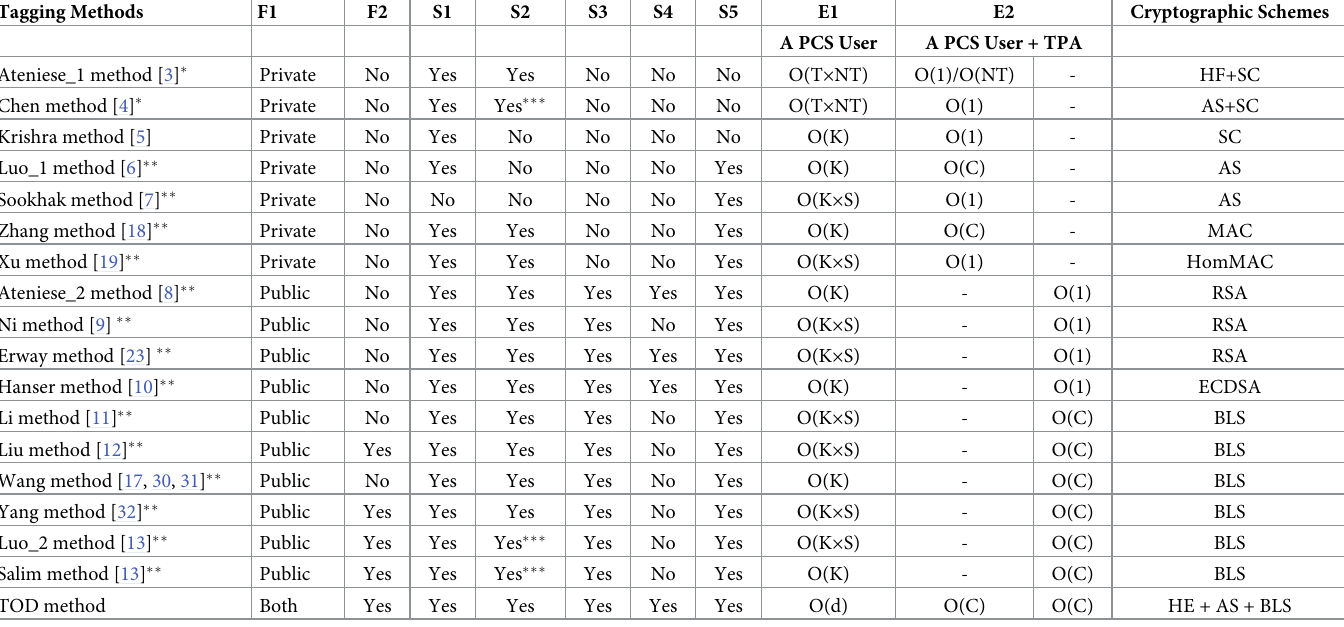
Table 9. Comparing TOD method with existing tagging methods against the specified requirements. Tagging